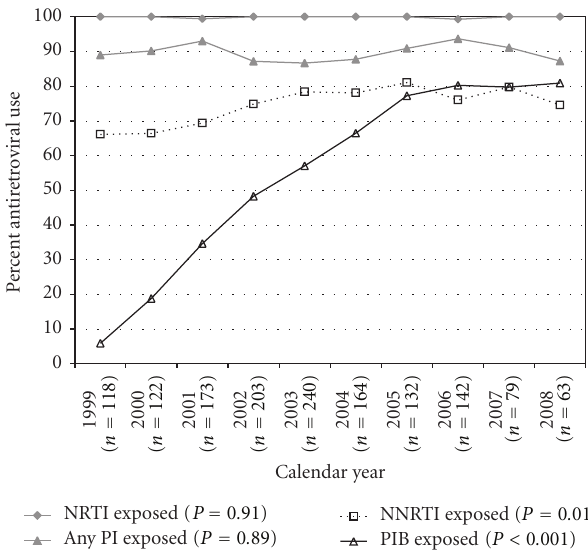
Figure 2: Frequency of antiretroviral exposures, according to ARV class, among viremic (HIV viral load > 1,000 copies/mL) patients who underwent genotypic testing in the HIV Outpatient Study, 1999–2008. Note: Any “PI exposed” included ritonavir-boosted and unboosted regimens. “PIB exposed” included only ritonavir- boosted